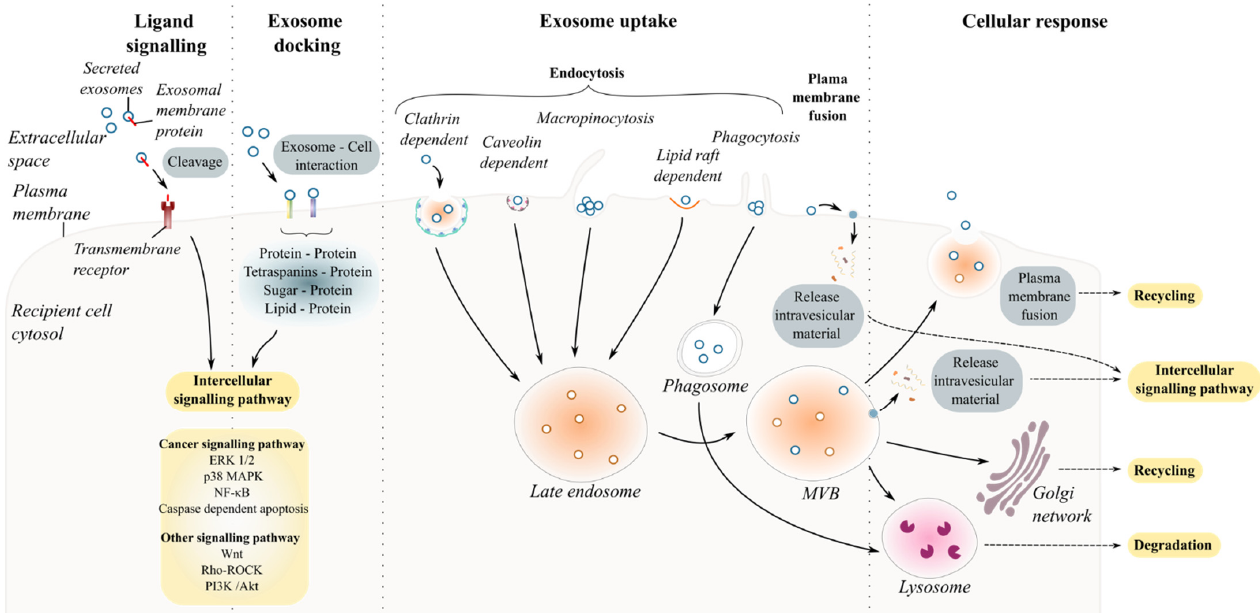
Figure 2. Exosome and recipient cell communication. Schematic diagram summarizing exosome–cell interactions. Once secreted into the extracellular space, exosomes mediate cellular responses via distinct pathways. Exosomes are described as messengers carrying functional cargo that can alter the physiology of the targeted cell once internalized. However, exosome uptake and/or direct contact with the targeted cell to mediate cell–exosome communication are not always required. Indirect interaction between secreted vesicles and cells is possible through soluble ligand signalling. Exosomes carry transmembrane proteins on their surface, accessible for cleavage by proteases to produce soluble forms of proteins that interact with specific receptors on the plasma membrane of recipient cells. Upon reaching the intended recipient cell, exosomes can dock at the plasma membrane. Following the anchorage of the vesicles, the activation of multiple distinct intercellular signalling pathways might occur via ligand/receptor interaction, also known as juxtacrine signalling. Most studies, however, describe the internalization of exosomes by the recipient cells. Exosome uptake involves several mechanisms of endocytosis including: (1) clathrin-dependent mechanism, (2) caveolin-mediated endocytosis, (3) macropinocytosis, (4) phagocytosis, and (5) lipid-raft dependent endocytosis. To release their content into the cytoplasm, secreted exosomes can directly fuse with the plasma membrane. The vesicle–cell interaction generates distinct cellular responses. Communication mediated by ligand signalling, Juxtacrine signalling or direct fusion with the plasma membrane possibly results in intercellular signalling pathway activation. On the other hand, once endocytosed by the cells, exosomal contents are systematically released to the endocytic compartments and are more likely to undergo degradation via fusion of endosomes with lysosomes. Some vesicles, however, have been described to escape degradation by back fusion of the exosomes containing MVB with the PM or by transport of exosomes towards the Golgi apparatus. MVB: Multivesicular bodies.